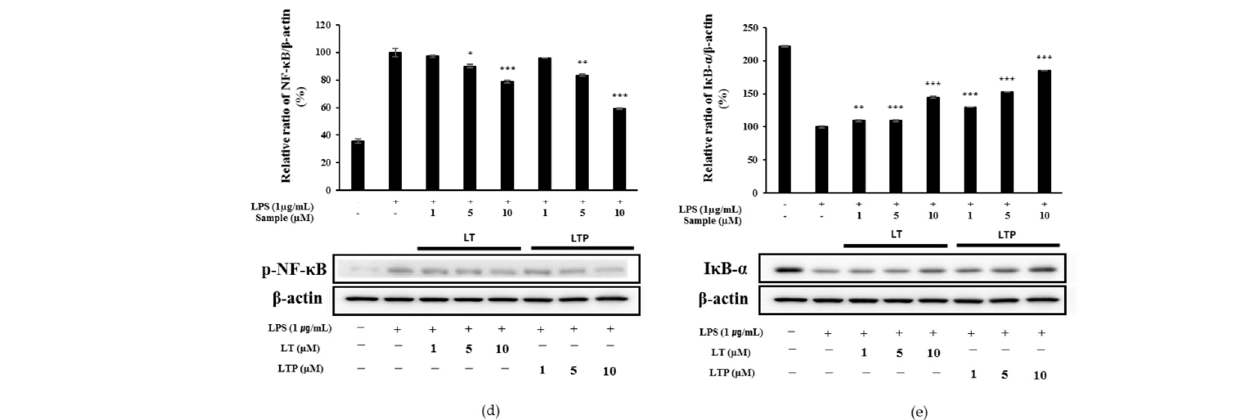
Figure 6. Effects of LT and LTP on the expression levels of mitogen-activated protein kinase (MAPK) and nuclear factor-kappa B (NF- κ B) in LPS-stimulated RAW 264.7 cells for ( a ) p38, ( b ) extracellular signal-regulated kinase (ERK), ( c ) c-jun NH 2 -terminal kinase (JNK), ( d ) nuclear factor-kappa B (NF- κ B), and ( e ) I κ B- α . Data are expressed as mean ± SD from three independent experiments (* p < 0.05, ** p < 0.01, and *** p < 0.001, compared to the LPS-treated group).